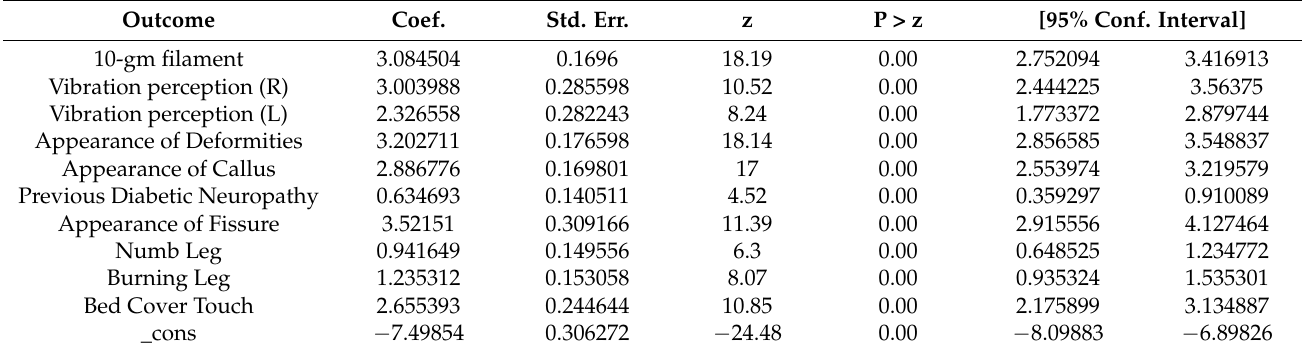
Table 4. Logistic regression analysis for constructing the nomogram for predicting DSPN utilizing the top 10 variables by the extra tree feature ranking technique.